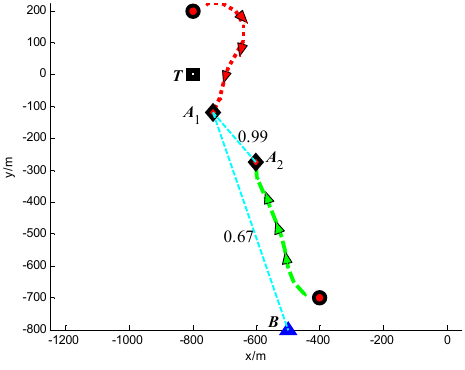
Figure 22. Trajectories of UAVs at t = 10 s (Group B in Scenario 2).